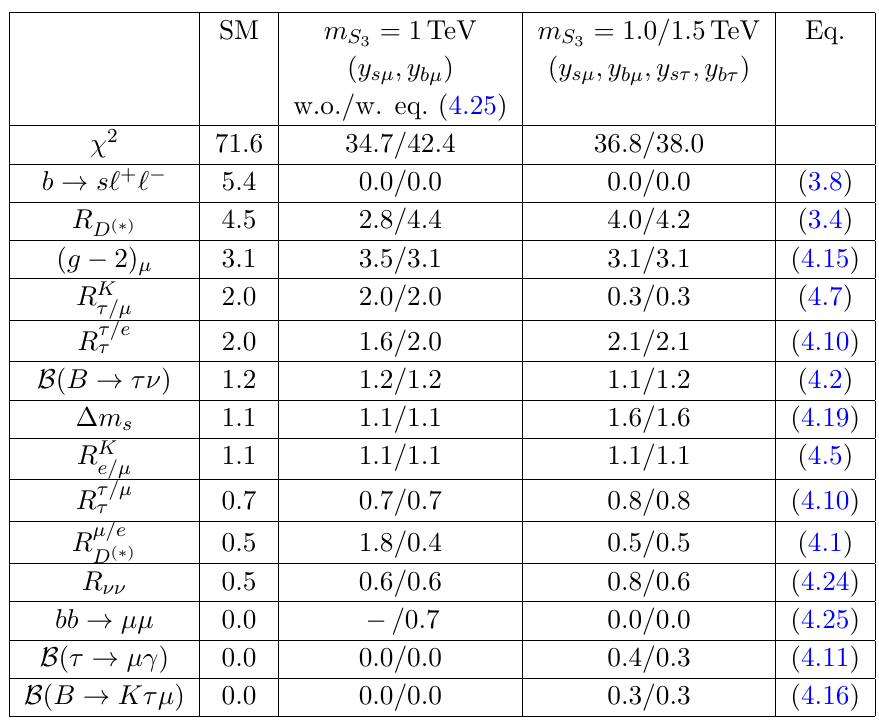
Table 1 . Observables that enter the global (cid:12)t with their pulls in (cid:27) in the SM and S 3 scenarios. Third column represents the case when m S = 1 TeV and only y s(cid:22) ; y b(cid:22) are allowed, without/with 3 taking into account b (cid:22) b ! (cid:22)(cid:22) constraint. Fourth column represents the (cid:12)t of the y s(cid:22) , y b(cid:22) , y s(cid:28) , y